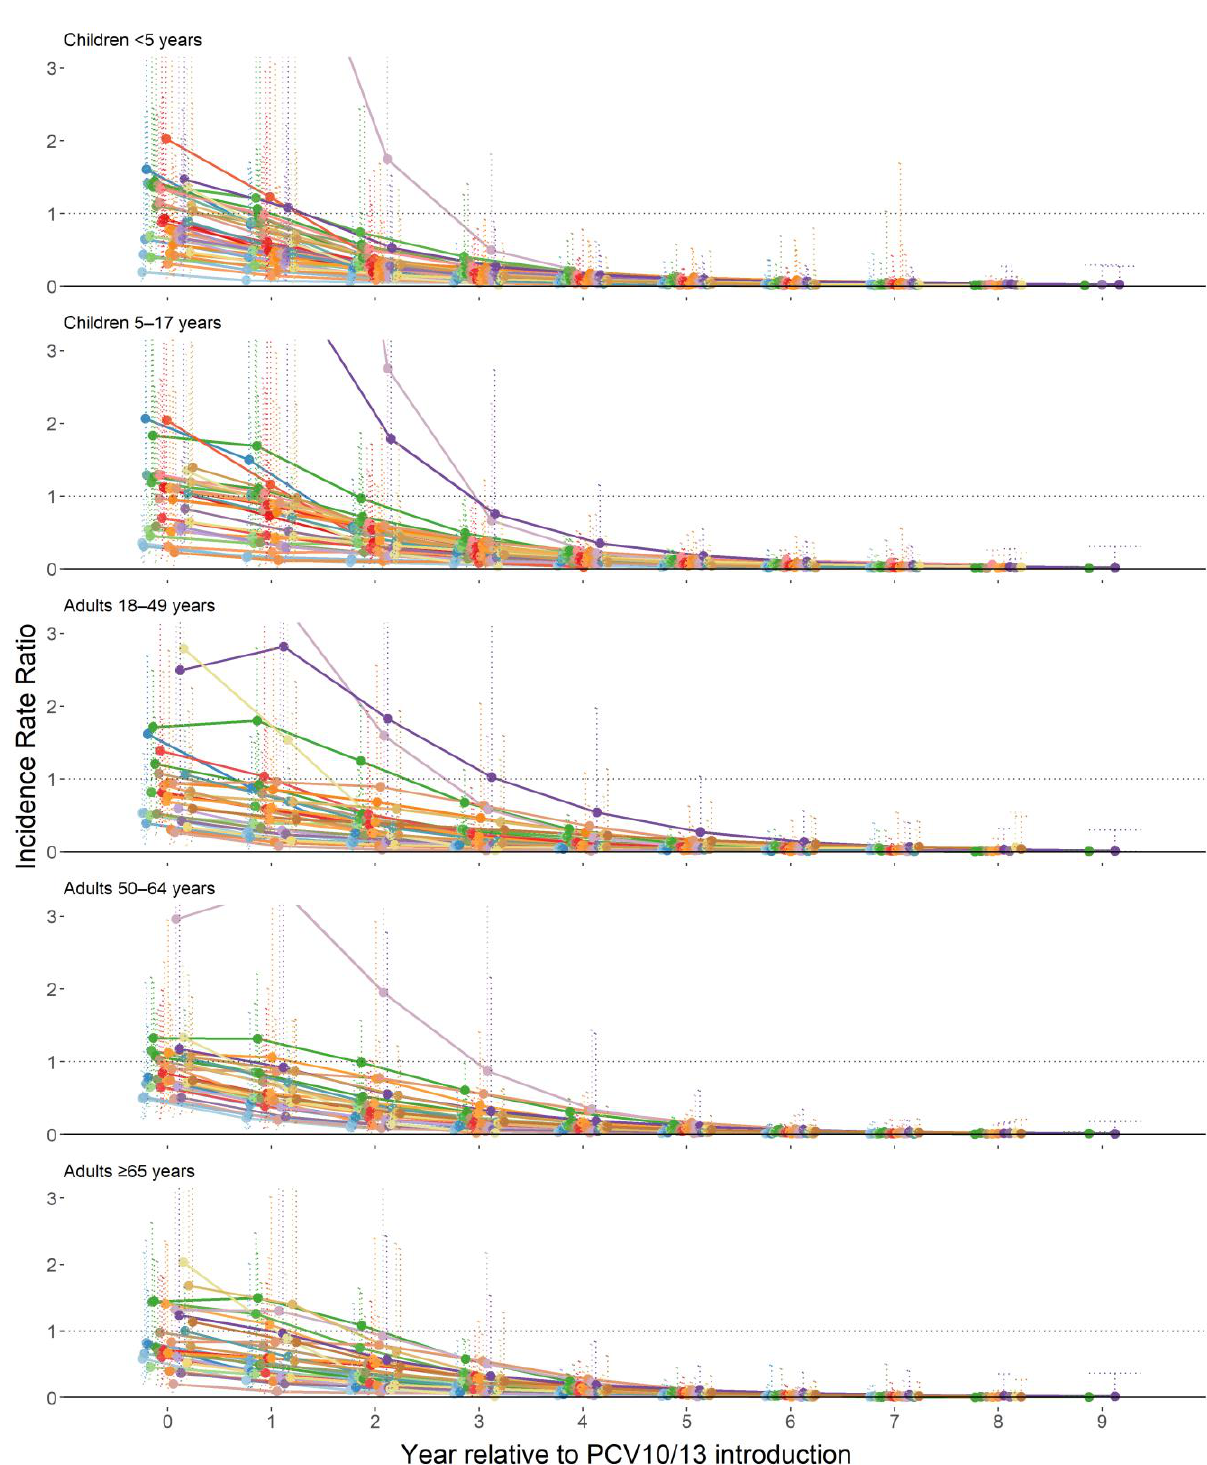
Figure 3. Site-specific modeled serotype 1 invasive pneumococcal disease incidence rate ratios comparing each post- PCV10/13 year to pre-PCV10/13 average, by age group.